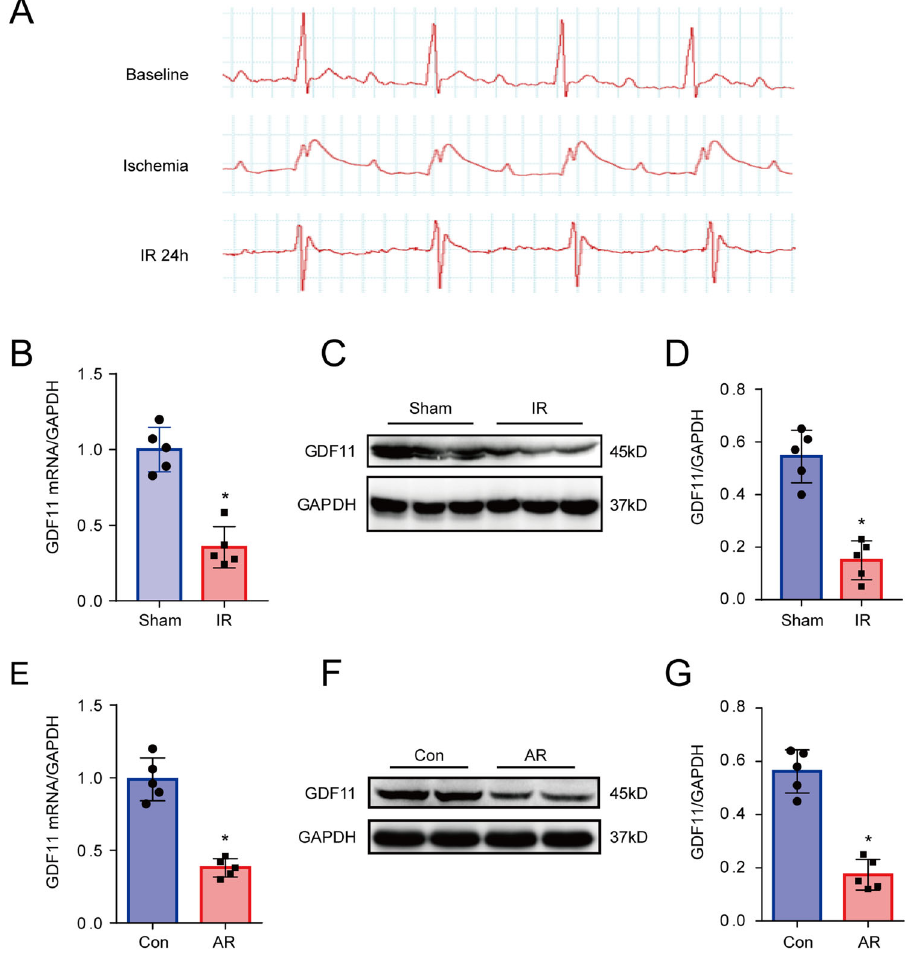
Fig. 2 GDF11 was downregulated in rodent cardiomyocytes following IR or AR. A Changes in the ST segment on ECG in response to myocardial IR in mice. B GDF11 mRNA levels in sham and IR mice at 24 h after surgery. C Representative western blots of GDF11 in sham and IR groups. D GDF11 protein levels in sham and IR mice at 24 h after surgery. E GDF11 mRNA levels in NRCMs subjected to AR. F Representative western blots of GDF11 in NRCMs subjected to AR. G GDF11 protein levels in NRCMs subjected to AR. * p < 0.05 vs. the sham group, n = 5 in each group. GDF11 growth differentiation factor 11, ECG electrocardiogram, IR ischemia/reperfusion, AR anoxia/reoxygenation, NRCMs neonatal rat